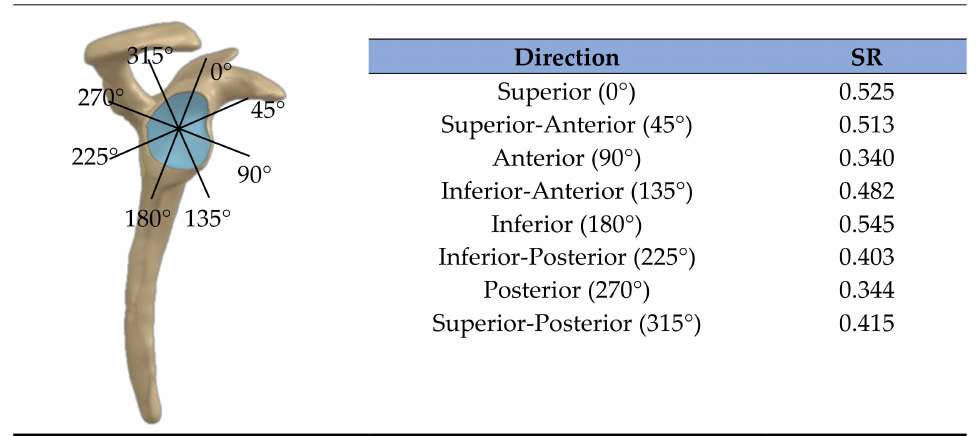
Figure 2. Stability ratios (SR) for eight directions of dislocation, in the glenoid plane, defined by the highest tolerable ratio between the shear and the compressive components of the GH reaction